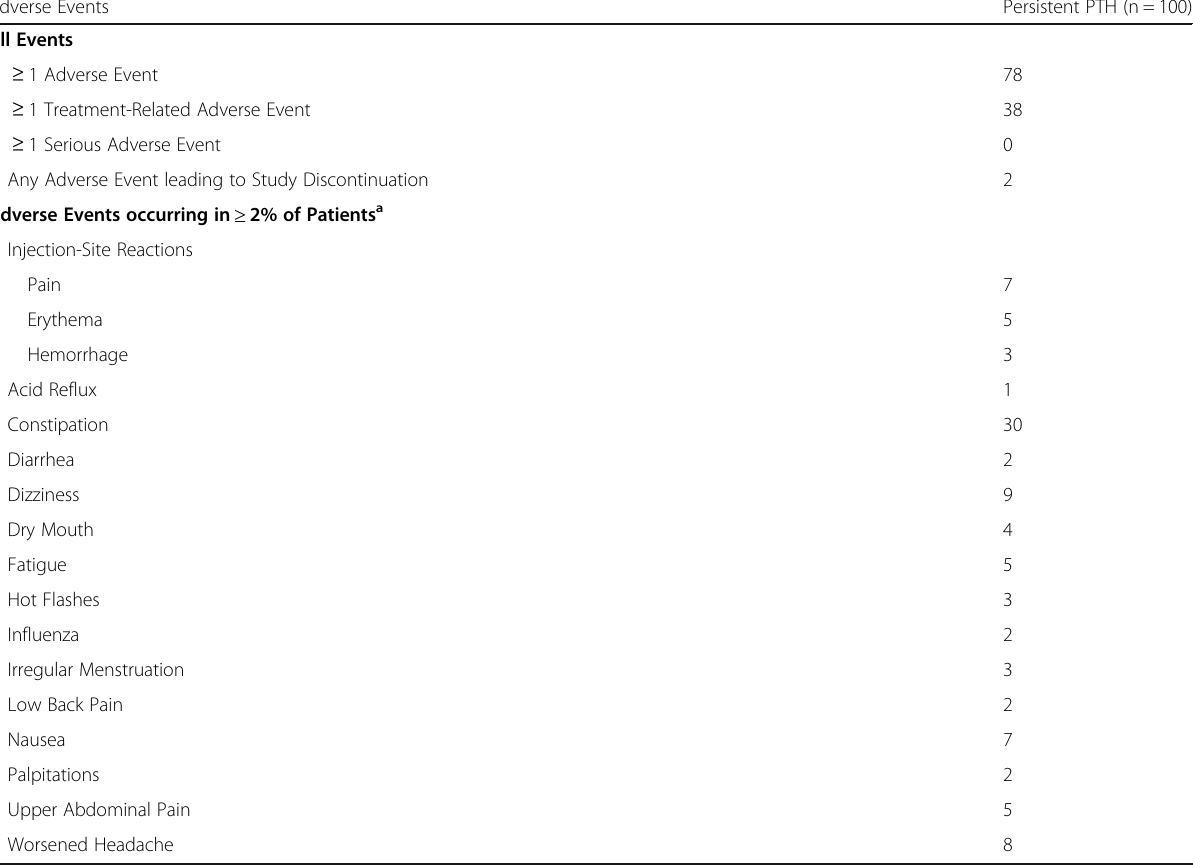
Table 3 Adverse Events during the 12-Week Open-Label Treatment Phase Adverse